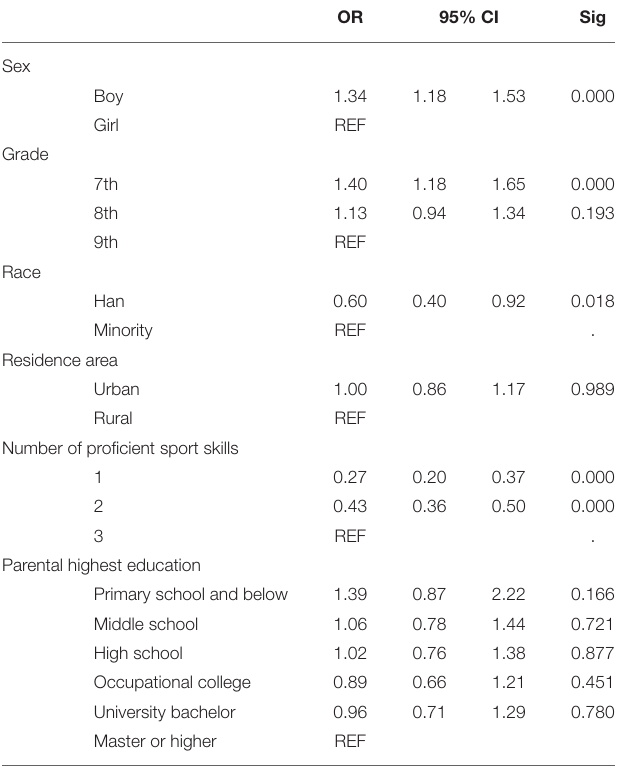
TABLE 3 | Odds ratio and 95% CI for socioeconomic factors concerning the participation in organized sport.